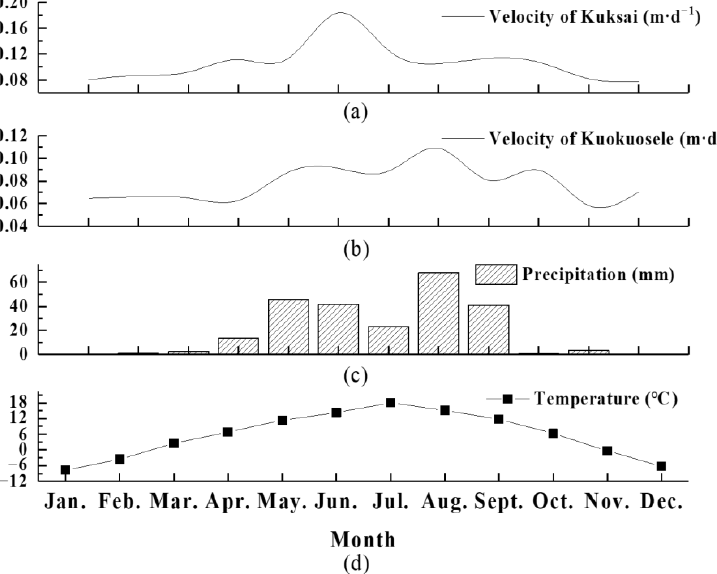
Figure 9. Changes in the velocity, precipitation, and average temperature of the Kuksai and Kuokuosele glaciers from 2015 to 2016. ( a ) Changes in the intra-annual velocity of the Kuksai Glacier; ( b ) changes in the intra-annual velocity of the Kuokuosele Glacier; ( c ) average monthly precipitation from 2015 to 2016; ( d ) average daily temperature from 2015 to 2016.